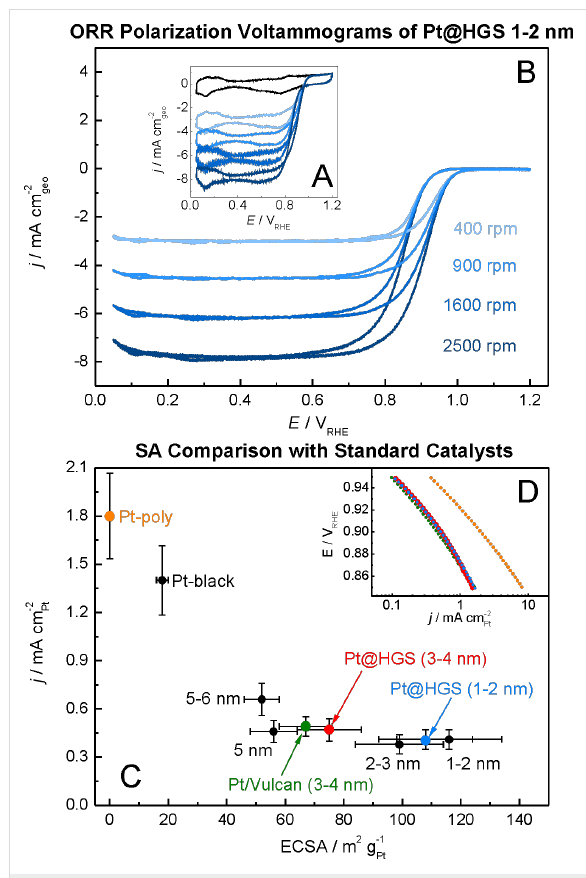
Figure 2: A) ORR cyclic voltammograms of Pt@HGS 1–2 nm in 0.1 M HClO 4 saturated with Ar (black) and with oxygen at (400–2500 rpm, blue) recorded at room temperature with a sweep rate of 0.05 V·s − 1 . B) Same as in A) after subtraction of capacitive currents. C) Plot of the specific activity as derived from the anodic scan at 0.9 V RHE versus the electrochemically active surface area of platinum illustrating the particle size dependent changes in activity. D) Tafel plots from a representative measurement of Pt-poly (orange), Pt@HGS 1–2 nm (blue), Pt@HGS 3–4 nm (red) and Pt/Vulcan 3–4 nm (green). The three Tafel plots of the Pt/C catalysts are almost